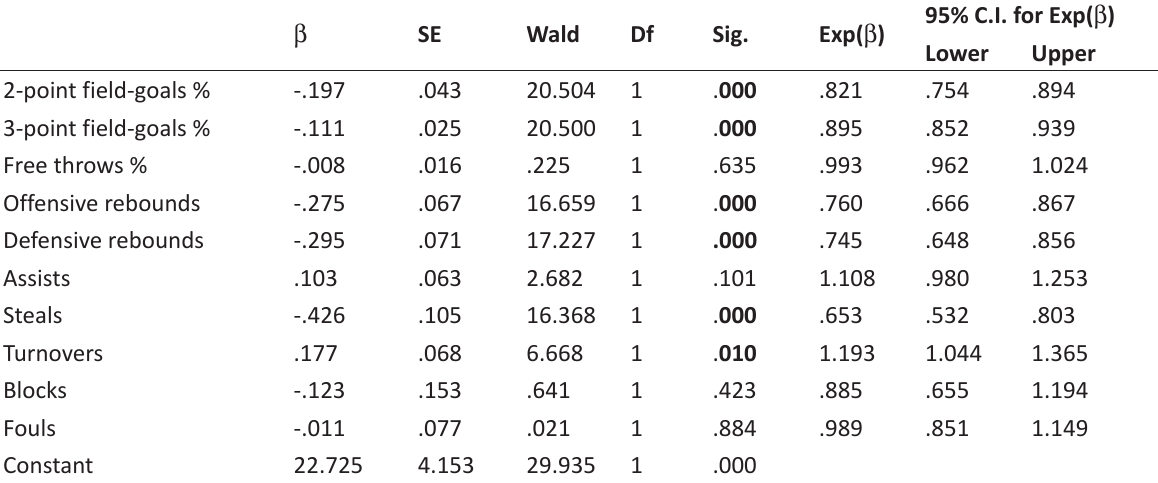
Table 3. Significance, probability and reliability limit values of the logistic